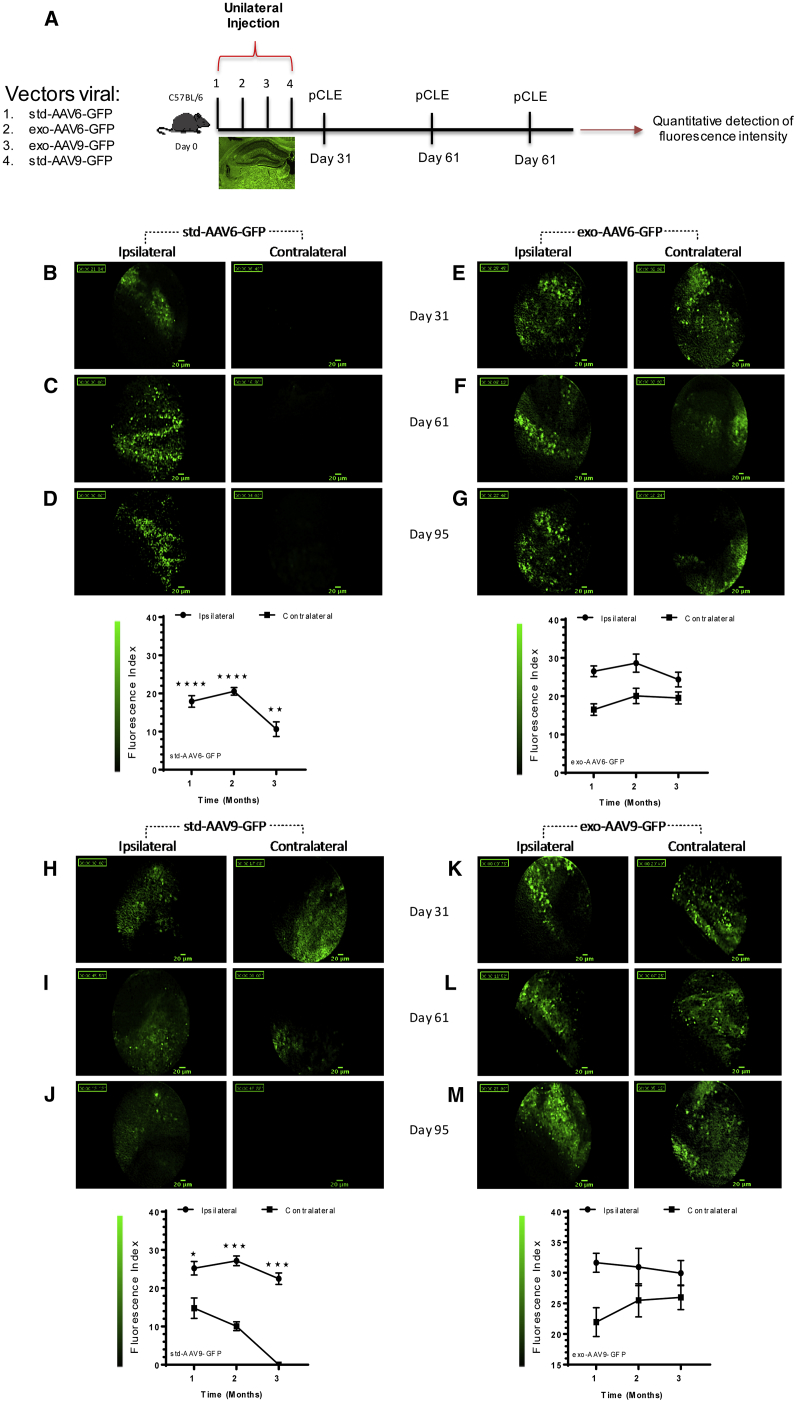
Detection of GFP Fluorescence via In Vivo Probe-Based Confocal Laser Endomicroscopy System(A) Schematic strategy in each group using stereotactic injection of std-AAV6-9 and exo-AAV6-9 vectors (2 μL) into the ipsilateral hemisphere and PBS (2 μL) into the contralateral hemisphere of adult C57BL/6 mice (n = 48) that underwent a confocal laser endomicroscopy system at 1, 2, and 3 months. Brain spreading of GFP fluorescent cells was detected using the confocal endoscope system (CellVizio-488) equipped with the S300 flexible microprobe containing 10,000 optical fibers that carry light from a continuous laser source at 488 nm to the living tissue. The GFP spreading in the contralateral hemisphere was monitored, introducing the flexible probe in the same small drill hole done on the skull in ipsilateral over viral vector injection sites of living mice using video data acquisition software (IC-Viewer, mkt). (B–G) GFP fluorescence brain spreading in the contralateral hemisphere at 1, 2, and 3 months from unilateral injection of (B–D) std-AAV6 with (E–G) exo-AAV6. (H–M) GFP fluorescence brain spreading in contralateral hemisphere at 1, 2, and 3 months from unilateral injection of (H–J) std-AAV9 with (K–M) exo-AAV9. Fluorescence pictures represent frames of 30- to 50-s acquired videos (scale bar 20 μm). Graphs represent the mean ± SEM between std-AAV6 compared to exo-AAV6 and std-AAV9 with exo-AAV9 of the relative fluorescence units (RFUs) detected over the time in the contralateral hemisphere by the 10,000 optical fibers per individual video frame. std-AAV6 (n = 8; interaction: F2,6 = 11.38, p = 0.0091; time: F2,6 = 11.38, p = 0.0091; spreading contralateral: F1,6 = 346.8, p < 0.0001. exo-AAV6 (n = 8; interaction: F2,6 = 1.078, p = 0.3982; time: F2,6 = 1.434, p = 0.3098; spreading contralateral: F1,6 = 27.53, p = 0.0019). std-AAV9 (n = 8; interaction: F2,6 = 7.064, p = 0.0265; time: F2,6 = 17.15, p = 0.0033; spreading contralateral: F1,6 = 161.8, p < 0.0001). exo-AAV9 (n = 8; interaction: F2,6 = 0.8112, p = 0.4877; time: F2,6 = 0.2112, p = 0.8154; spreading contralateral: F1,6 = 11.17, p = 0.0156). *p < 0.05, **p < 0.01, ***p < 0.001, ****p < 0.0001. Data are presented as mean ± SEM.